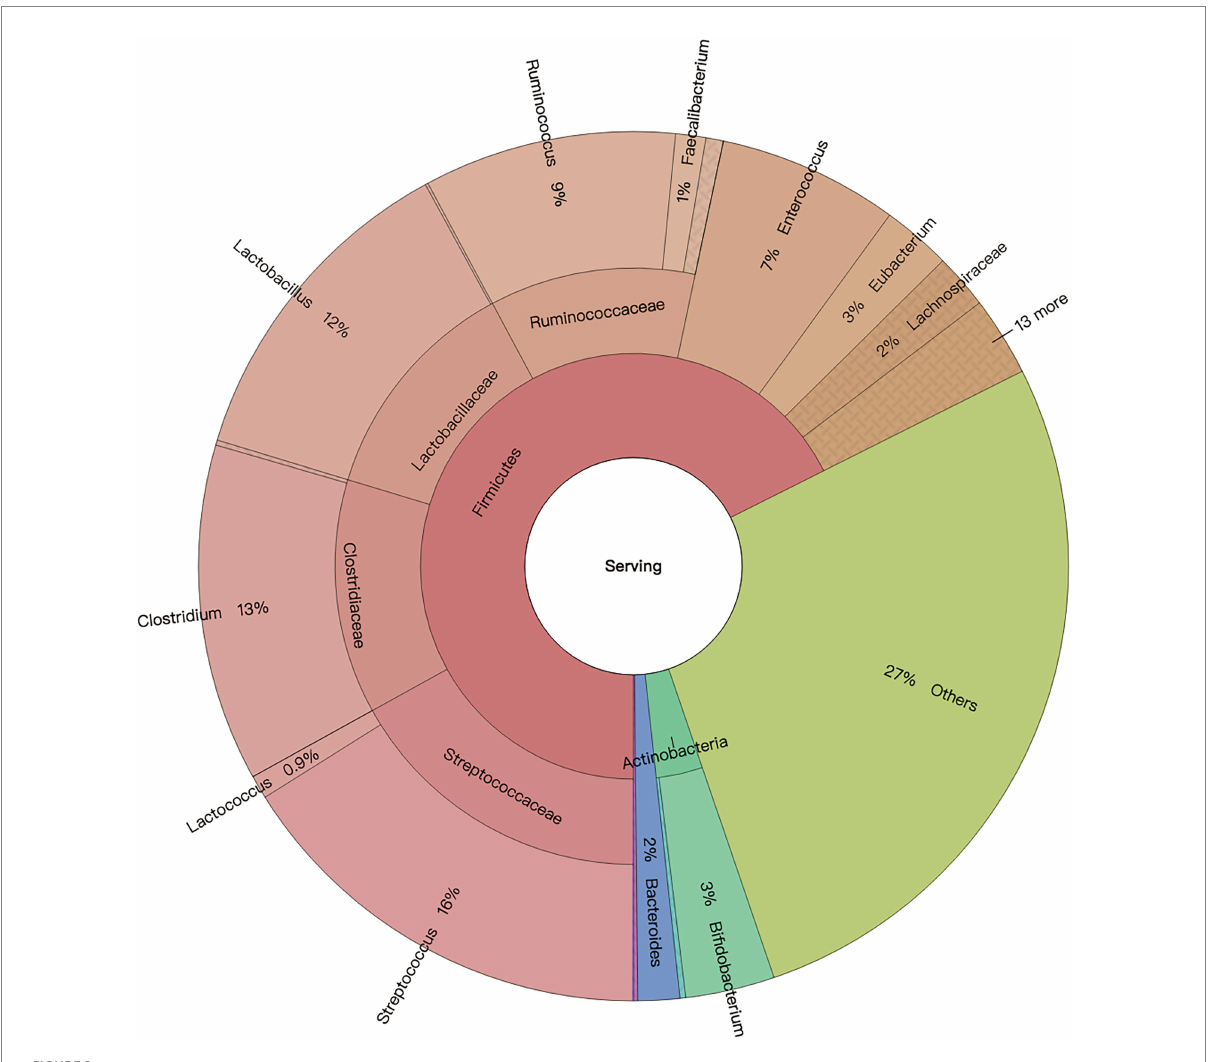
FIGURE 2 Colon bacterial composition of neonatal calves.